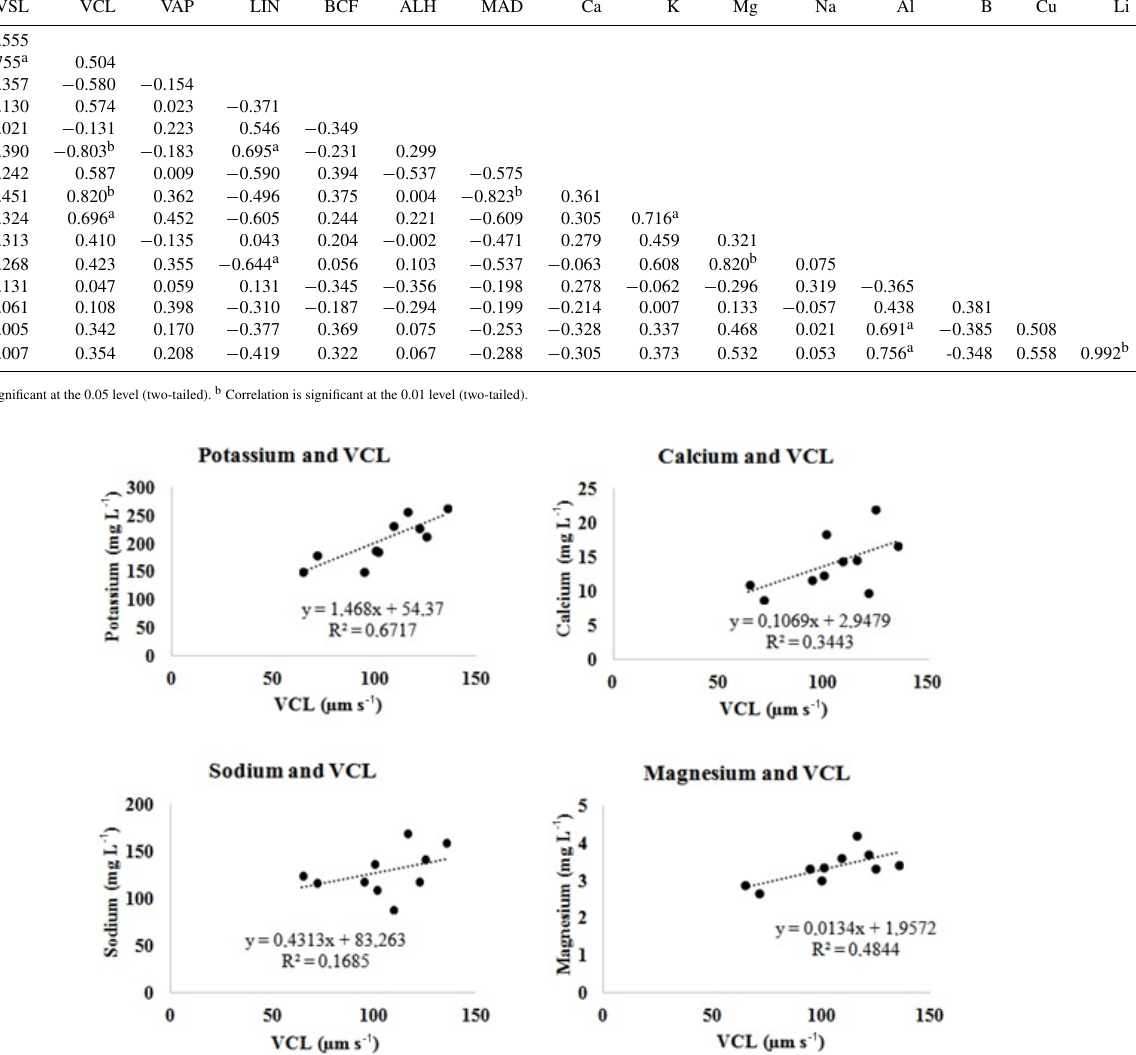
Positive linear regression relationships (weak in VSL